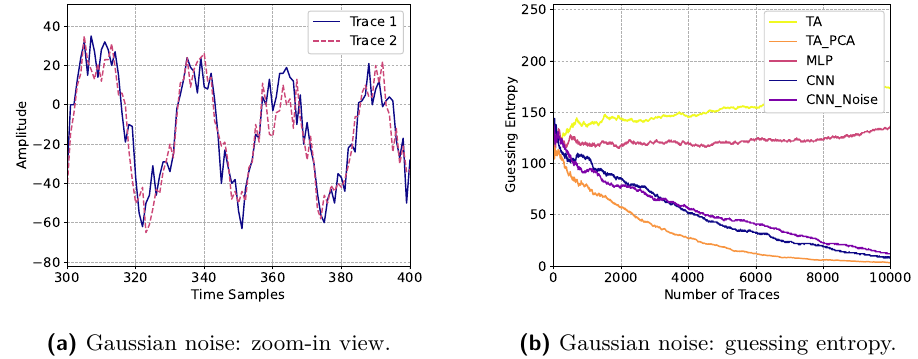
Figure 1: Gaussian noise: demonstration and its influence on guessing entropy.